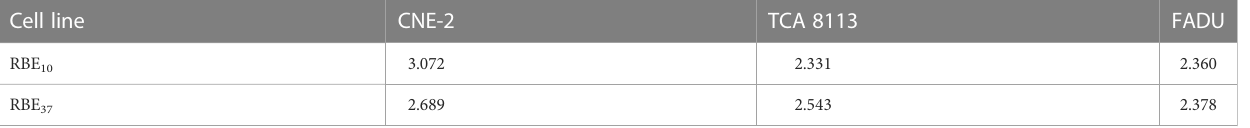
TABLE 2 RBE- relative biological effectiveness ; RBE 10 - the RBE at 10% survival level; RBE 37 - the RBE at 37% survival level . Cell